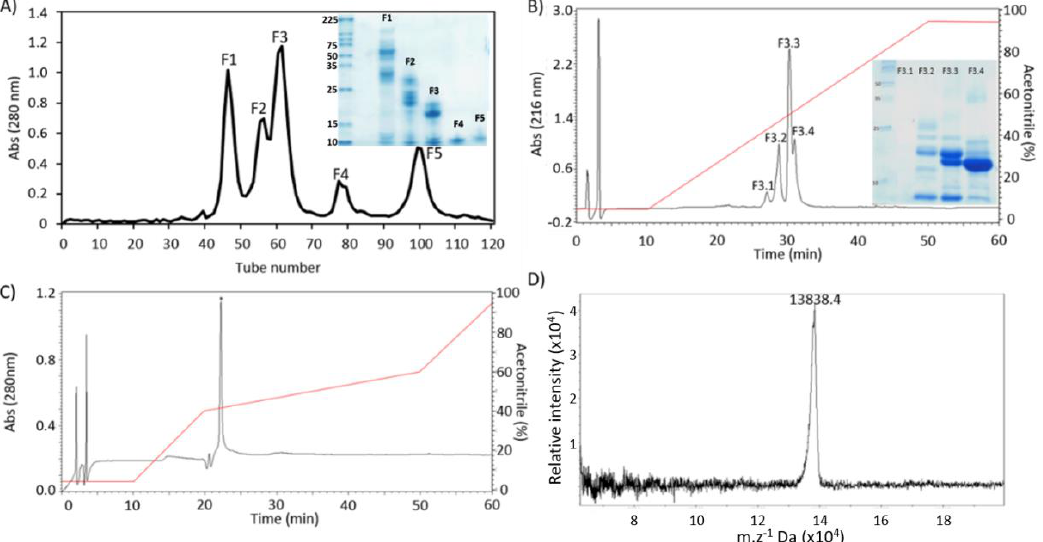
Figure 1. Purification steps of BmPLA2 from B. moojeni venom. ( A ) Separation profile of B. moojeni venom on Sephacryl S-100 column using 50 mM Ambic, pH 7.8. Inset: 12% SDS-PAGE showing peaks F1 to F5. ( B ) Profile of F3 peak on a RP-HPLC C18 column. Elution was performed using a linear gradient 5–95% of solvent B, for 60 min, at a flow rate of 1 mL.min −1 . Inset, 12% SDS-PAGE of peaks F3.1 to F3.4. ( C ) Profile of F3.4 on a RP-HPLC C18 column: Elution was performed using a stepwise gradient: 5% of solvent B to 10 min, 5–40% to 10–20 min, 40–60% to 20–50 min, 60–95% to 50–60 min at a flow rate of 1 mL.min −1 . ( D ) Molecular mass of BmPLA2, 13,838.4 Da, determined by MALDI-ToF.